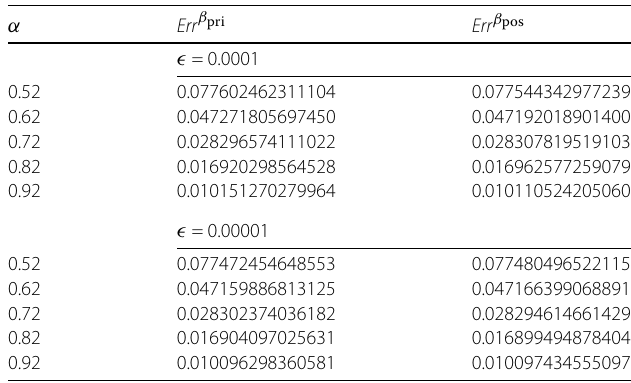
Table 3 Error estimates between the exact and regularized solutions for τ =